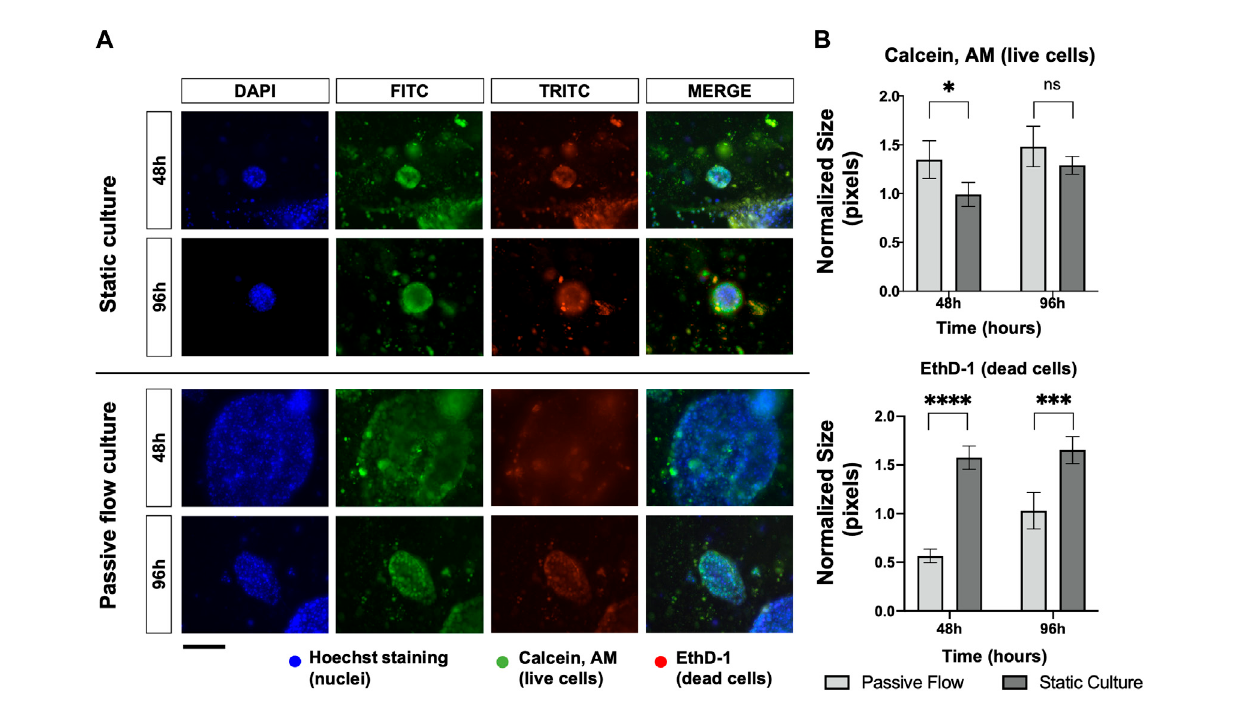
FIGURE 4 Proliferation and deathrate instatic anddynamiccultures: (A) Fluorescencemicroscopyimagesoforganoids labeled withHoescht33,342, Calcein, AM, and EthD-1. The nuclei of the cells are shown in blue, the live cells are shown in green, and the dead cells are shown in red. A comparison at 48 and 96 hbetweenstaticculturesandpassive fl owculturesisshown.Scalebar250 μ m; (B) Quanti fi cationof fl uorescencesignal:thenumberofredandgreen pixels was normalized by the number of blue pixels and mean ± SD is reported. The p -value was calculated using a two-tailed Student ’ s t -test. * p ≤ 0.05, ** p ≤ 0.01, *** p ≤ 0.001, and **** p ≤